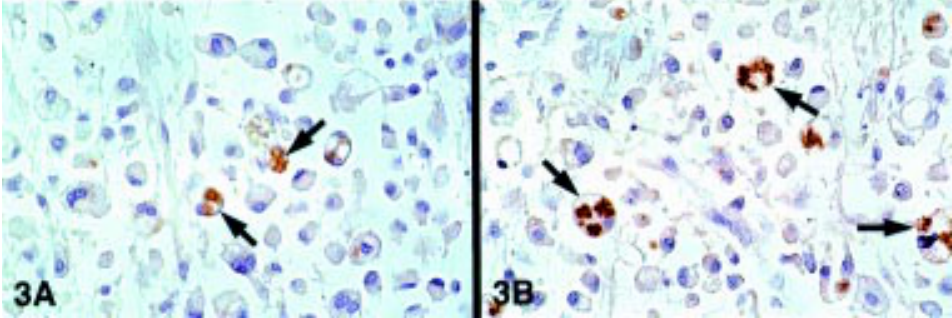
Figure 3. Versican and dermatan sulfate proteoglycan in the cen- ter of an active MS lesion. Each shows loss of extracellular versi- can (A) and dermatan sulfate proteoglycan (B) with staining for these molecules (arrows) in granules within the cytoplasm of foamy macrophages, indicating that they have been phagocy- tosed. Magnification = 514X for